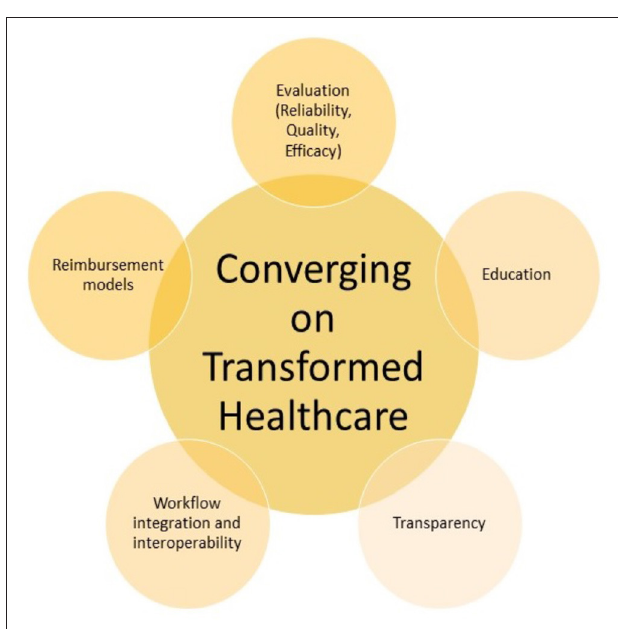
FIGURE 5 | Roadmap for transformed health